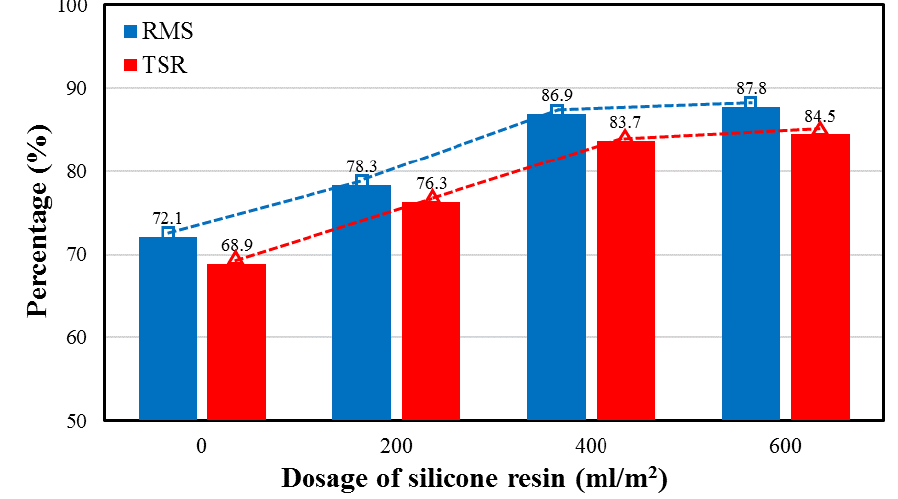
Figure 12. Moisture susceptibility of asphalt mixture at various silicone dosages.